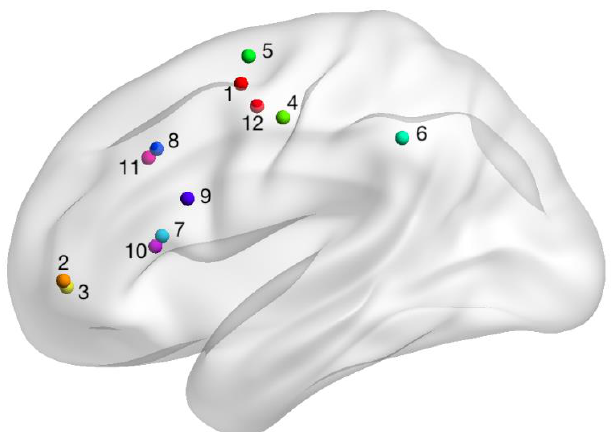
Figure 3. Plotted fMRI-navigated stimulation sites for all study participants on a model of a standard left hemisphere. Numbers correspond to the participant number (Table 1). Table 1. Demographics, clinical characteristics, tDCS allocation, and stimulation site for study participants.